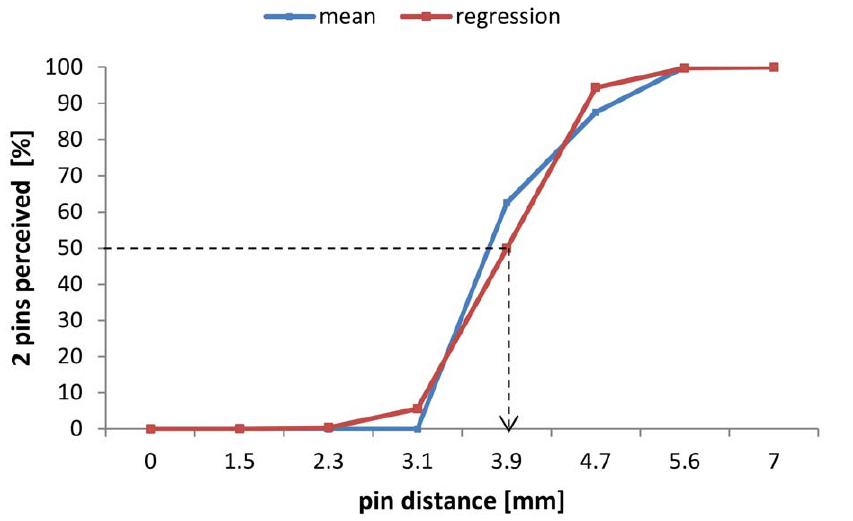
Figure 6. Psychometric function for two-point discrimination performance. Example of the typical two-point discrimination performance of an older adult. Correct responses in percentages (blue squares) are plotted as a function of needle distances. Based on these results, a logistic regression is calculated (red squares). The 50% level of correct responses (dashed line) determines the individual 2-point discrimination threshold (arrow).